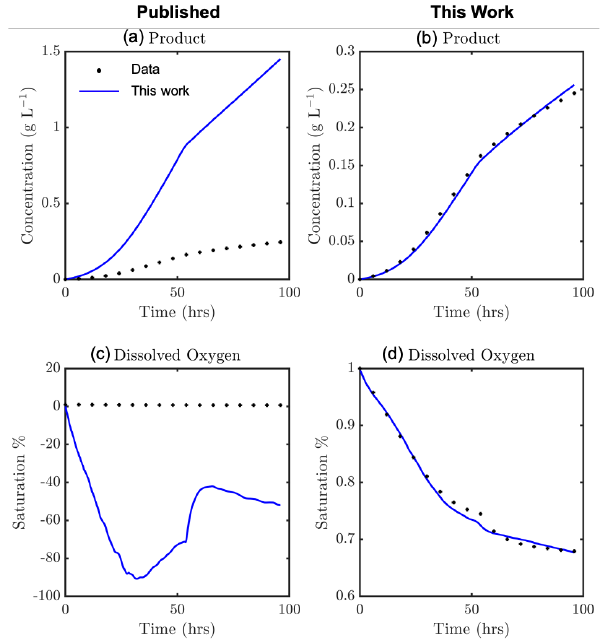
Figure 4. Modeled vs. experimental product concentrations from ( a ) published model [39,40] and ( b ) this work and dissolved oxygen concentrations from ( c ) published model [39,40] and ( d ) this work.